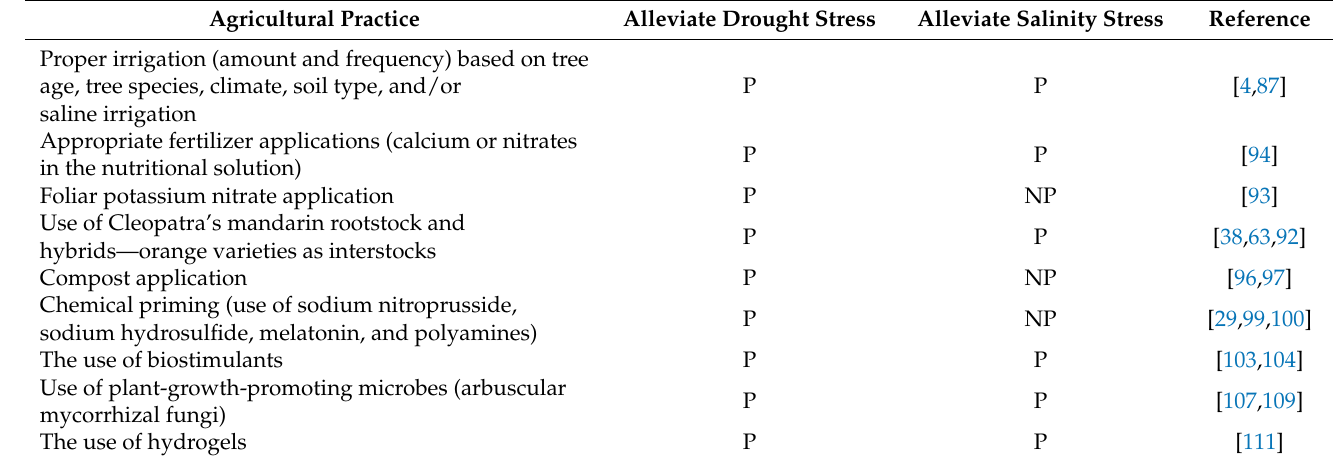
Table 2. Summarizing the main agricultural practices to alleviate drought/salinity